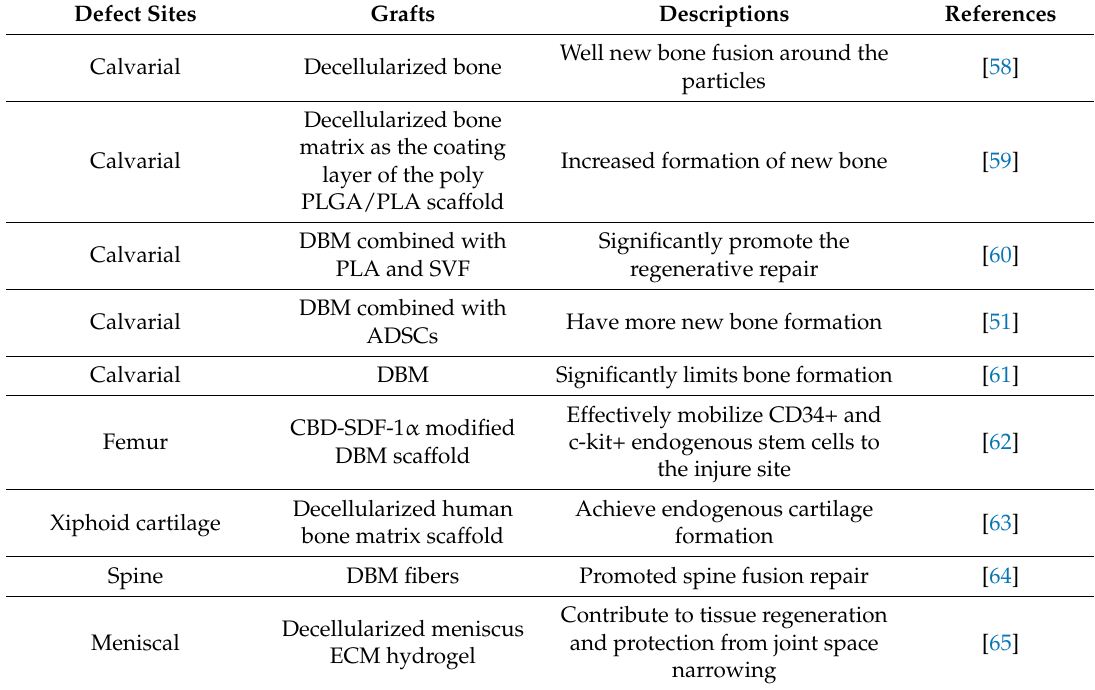
Table 2. The in vivo results of different natural bone grafts implanted in different sites in rat bone defect